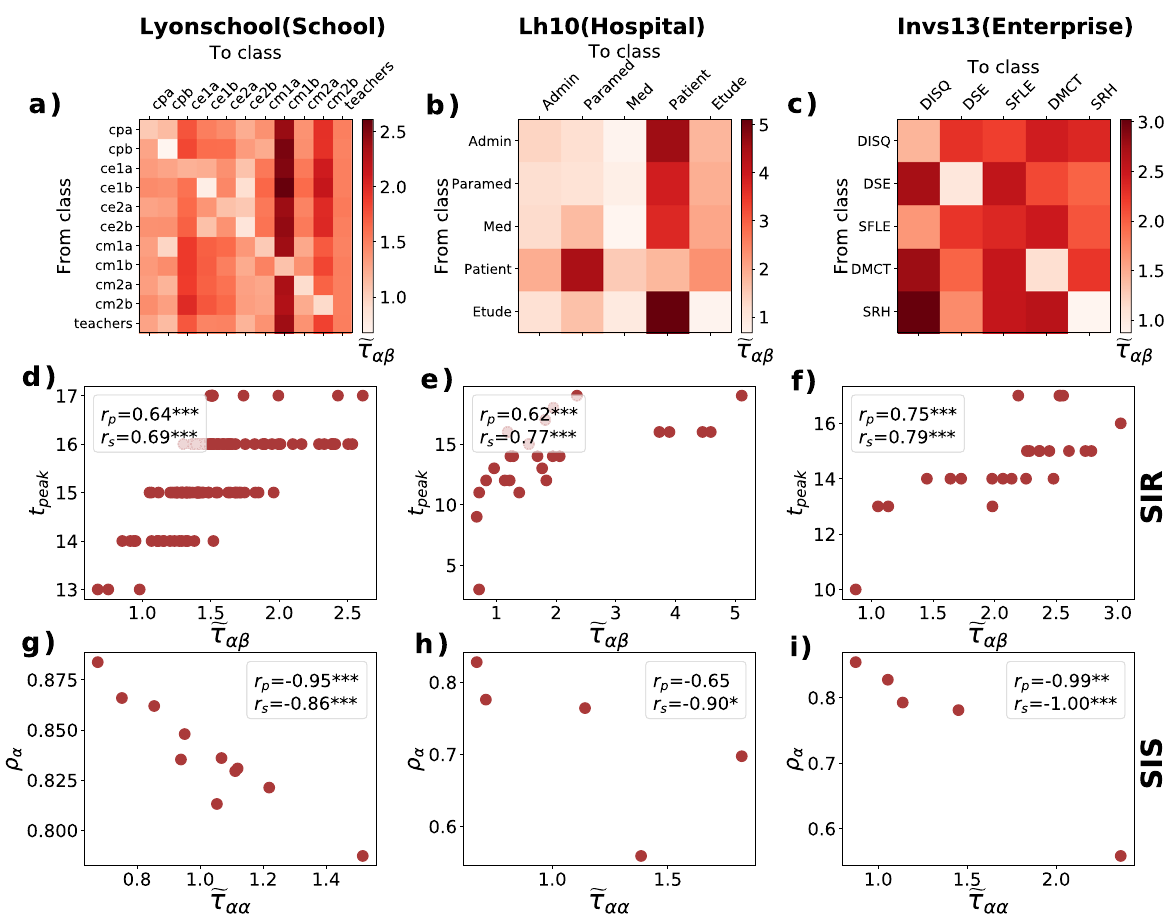
Fig. 6 Class mean fi rst passage times and the spread of epidemics in contact networks. a – c Class mean fi rst passage times in contact networks corresponding to a school, a hospital and an enterprise. Each acronym corresponds to a class in the case of the school, a role in the case of the hospital and a department in the case of the enterprise. d – f Relation between the normalised class mean fi rst passage times from class α to class β e τ αβ and the time steps until the peak of the epidemic t peak in a susceptible – infected – recovered (SIR) model. g – i Relation between the return times e τ αα and the fraction of infected individuals in each class in the stationary state ρ α in a susceptible – infected – susceptible (SIS) model. Simulations were performed using the parameters β = 0.7 and μ = 0.1. r p stands for the Pearson correlation coef fi cient while r s for the Spearman correlation coef fi cient. The signi fi cance is determined by the p value (* p < 0.05, ** p < 0.01, *** p <